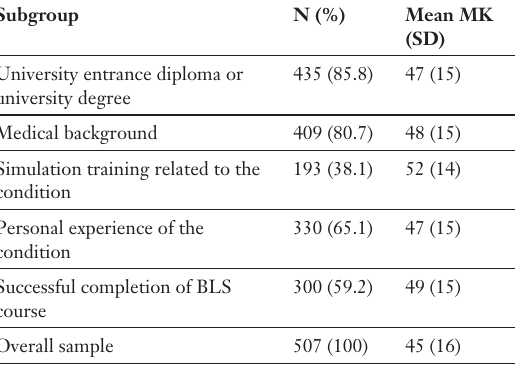
Differences in participants’ answers.